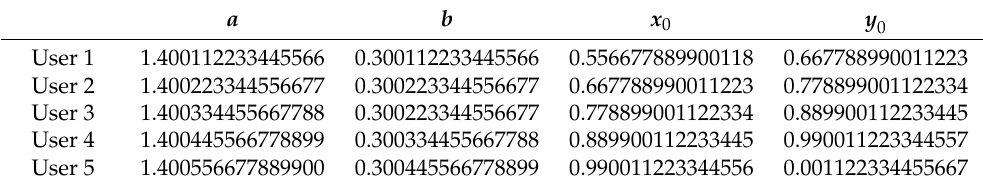
Table 4. Secret key definition for the decryption process of the five users.